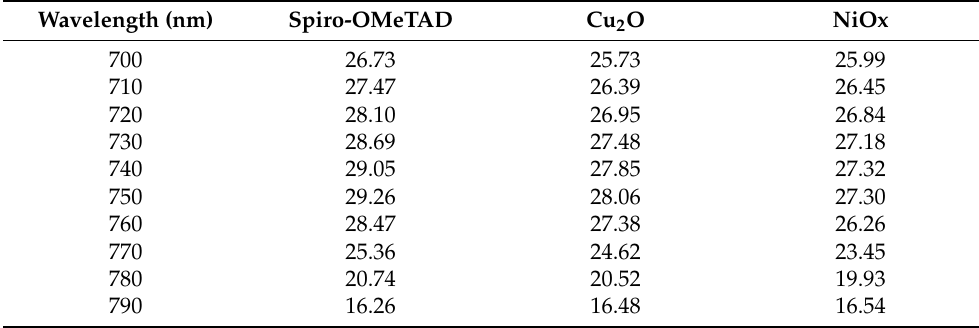
Table 3. Effect of using different materials as an HTM on the efficiency of an inverted planar perovskite solar